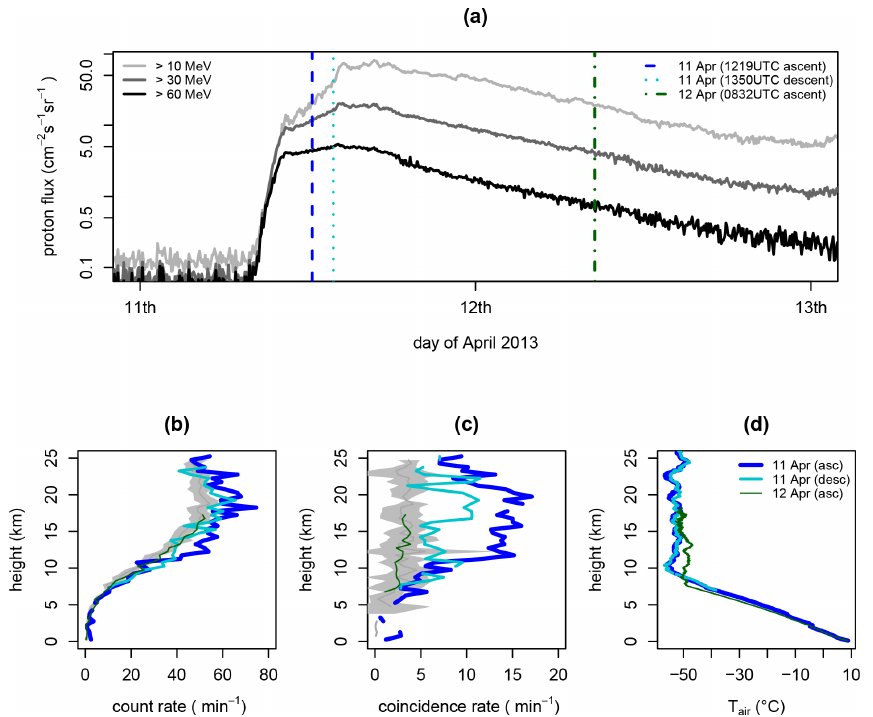
Figure 12. Geigersonde flights during the solar flare of 11 April 2013. (a) Proton flux time series from satellite (GOES-13) detectors for proton energies greater than 10MeV (light grey line), 30MeV (dark grey line) and 60MeV (black line). Vertical lines mark Geigersonde launch times from Reading for 11 and 12 April (dashed and dash dotted), and the burst time beginning the descent on 11 April (dotted). Soundings of (b) count rate and (c) tube coincidence rate from ascent and descent on 11 April (thick and medium lines), and ascent on 12 April (thin line). Grey bands show confidence range (2 standard errors) from undisturbed flights. (d) Air temperature profiles on 11 and 12 April. (Adapted from Nicoll and Harrison,